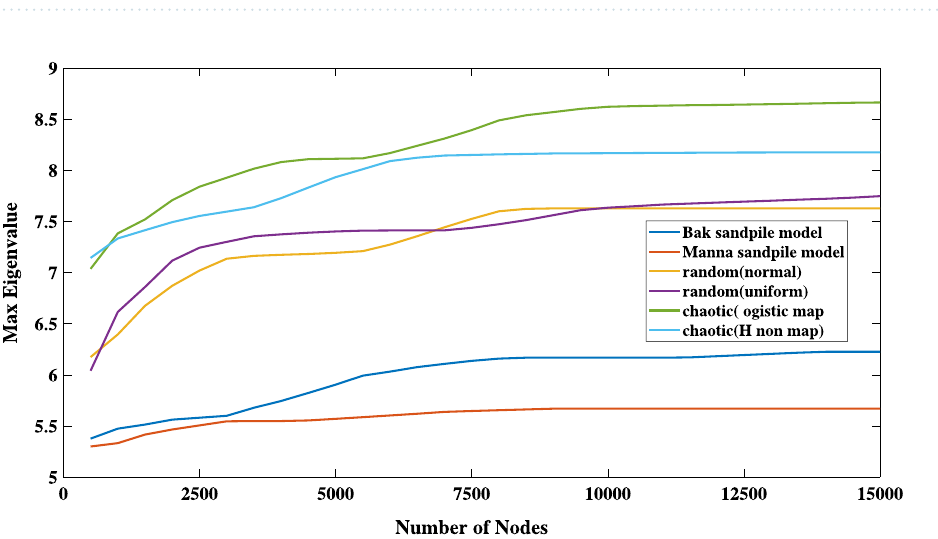
Figure 4. The maximum eigenvalues against the number of nodes for the constructed network for different TS.